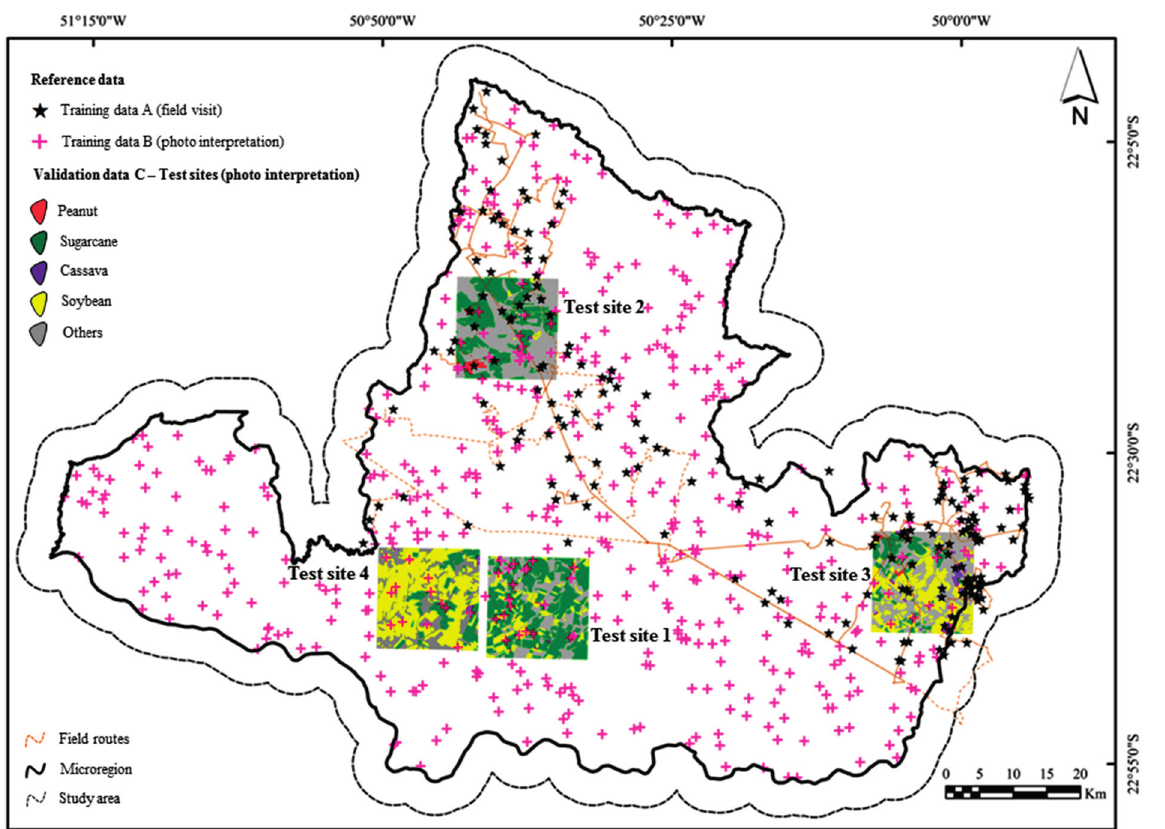
Figure 4. Reference information collected within the Assis microregion.